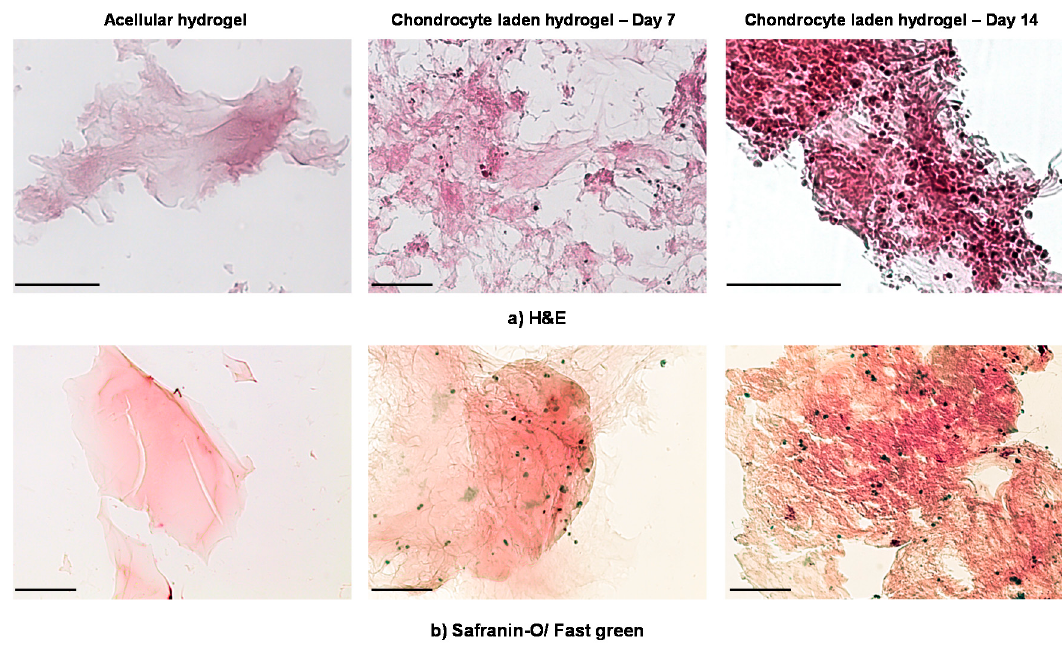
Figure 9. Histological analysis with ( a ) hematoxylin & eosin (H&E) staining and ( b ) Safranin O / Fast Green staining for chondrocyte-laden MeHA hydrogels (7.5 w / v%) extracted from the osteochondral platform after 7 and 14 days of culture. The scale bar corresponds to 100 μ m.